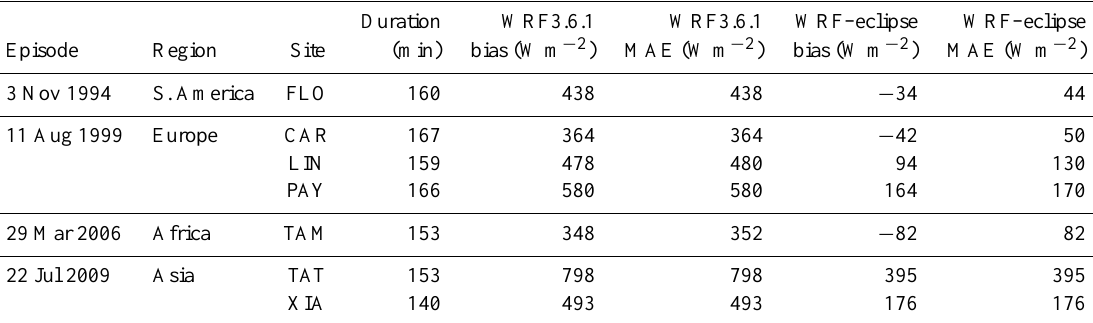
Table 2. Bias and MAE of the GHI forecasts produced by WRF3.6.1 and WRF–eclipse for the period in which the obscuration is greater than zero and the solar zenith angle is less than 80 ◦